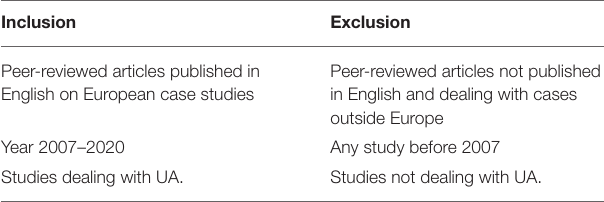
TABLE 2 | Inclusion and exclusion criteria a .